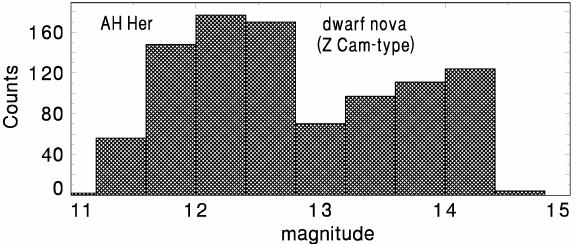
Figure 2: Statistical distribution of the observed data in the dwarf nova AH Her (from Fig. 1).